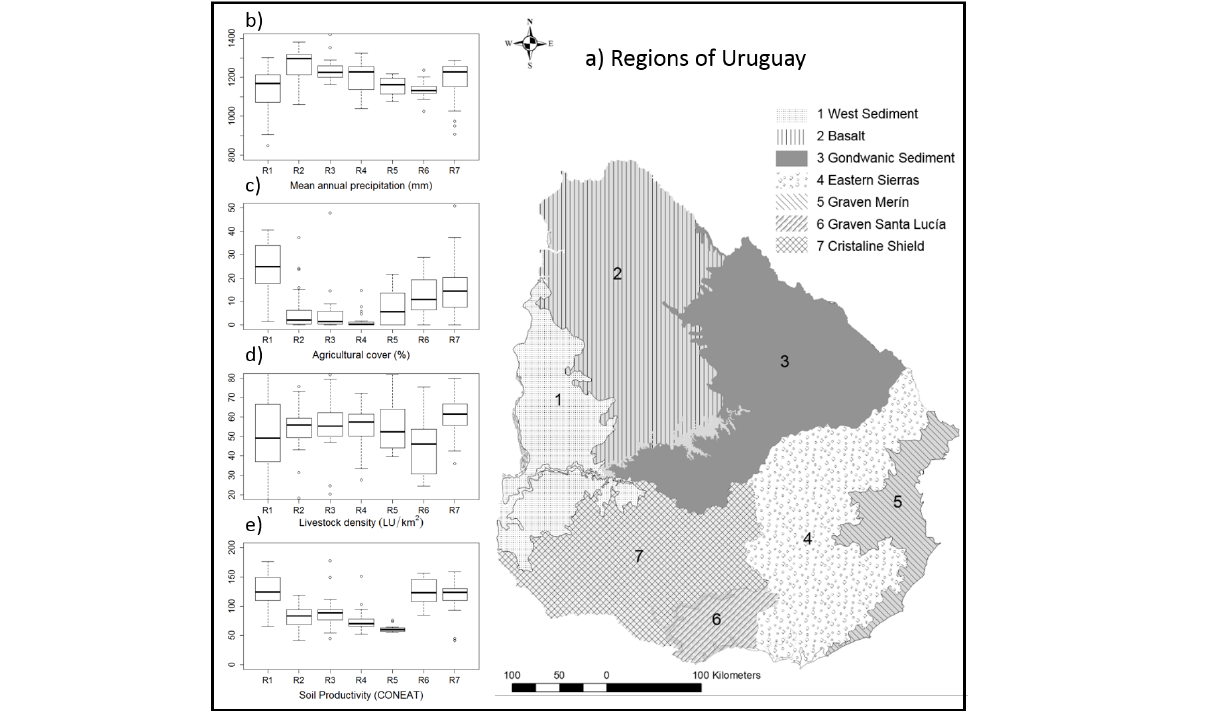
Fig. 2 . Regions of Uruguay. (a) Edapho-topographic regions of Uruguay used in the statistical analysis. Box plots show values of mean annual precipitation (b), agricultural cover (c), livestock density (d), and soil productivity (e) for each region. LU, livestock